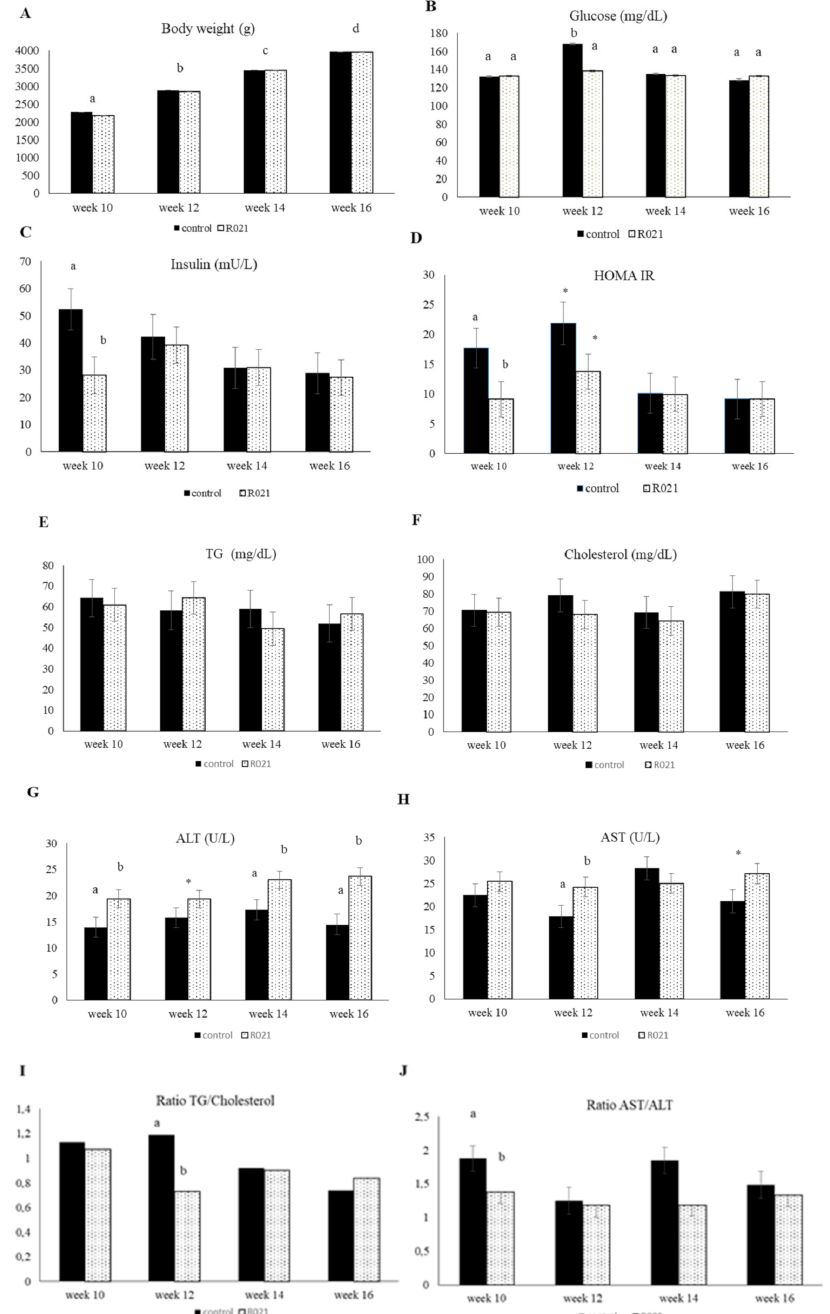
Figure 5. Live body weight (LBW) and metabolic parameters during the juvenile phase (10 to 16 weeks) of female progeny from ad libitum fed mothers (Control group) and fed restricted females (105 g/day) during the first two-thirds of gestation and re-fed ad libitum until term (R021 group). ( A ) Live body weight (LBW); carbohydrate metabolites: ( B ) glucose and ( C ) insulin; ( D ) HOMA IR index; lipid metabolism: ( E ) triglycerides, ( F ) cholesterol and ( I ) ratio TG/cholesterol; hepatic enzymes: ( G ) ALT, ( H ) AST and ( J ) ratio AST/ALT. Different letters mean significant differences ( p < 0.05) between groups within weeks, except in LBW that denote differences between weeks. HOMA IR index: [insulin (mU/L) × (glucose (mg/dL)/18)]/22.5; ALT: serum alanine transaminase; AST: serum aspartate transaminase. * denotes p =